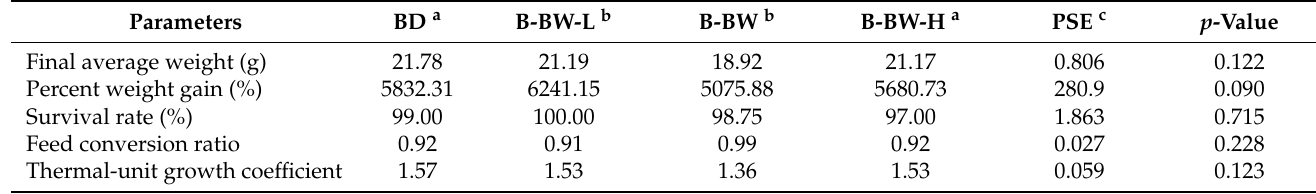
Table 5. Growth performance of channel catfish cultured in flow-through system for 8 weeks fed different inclusion levels of BiOWiSH, stocked at 40 fish tank − 1 with an initial weight at 0.36 ± 0.03 g (Mean ± SEM). BD = basal diet; BiOWiSH FeedBuilder Syn3 with low 1.8 × 10 4 CFU g − 1